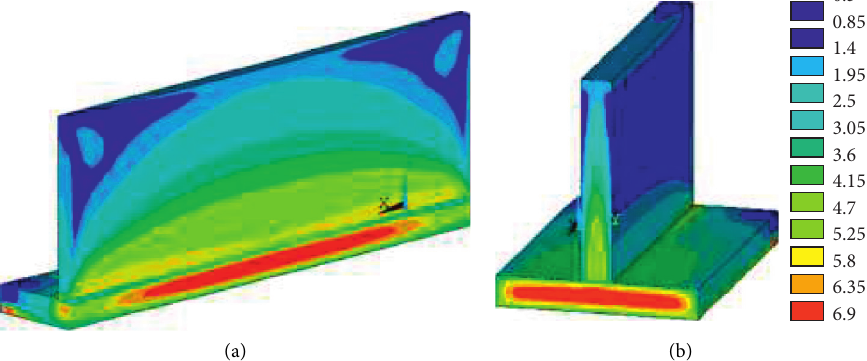
Figure 5: Stress envelope diagram of sluice model for BC along and vertical to flow direction (MPa).